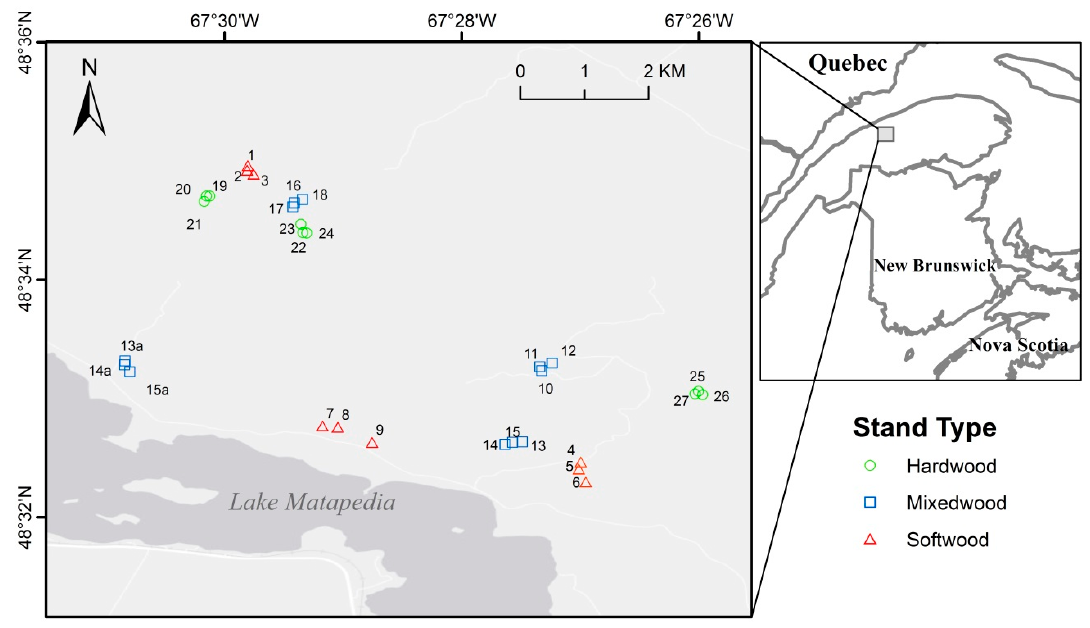
Figure 1. Locations of 27 plots sampled near Amqui, Quebec, by stand type.